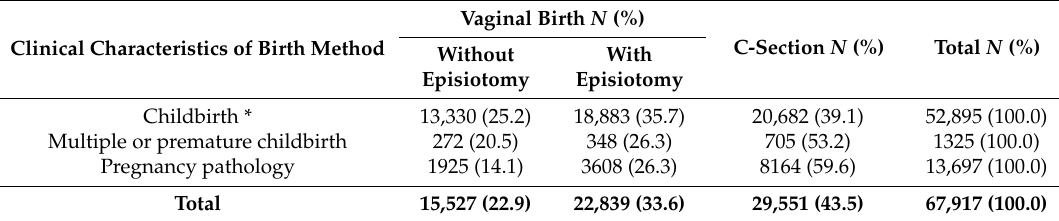
Table 4. Birth method in women giving birth in the years 2013–2014 in the Malopolska province; (Chi-squared test results Chi-squared(4) = 1980.1; p <